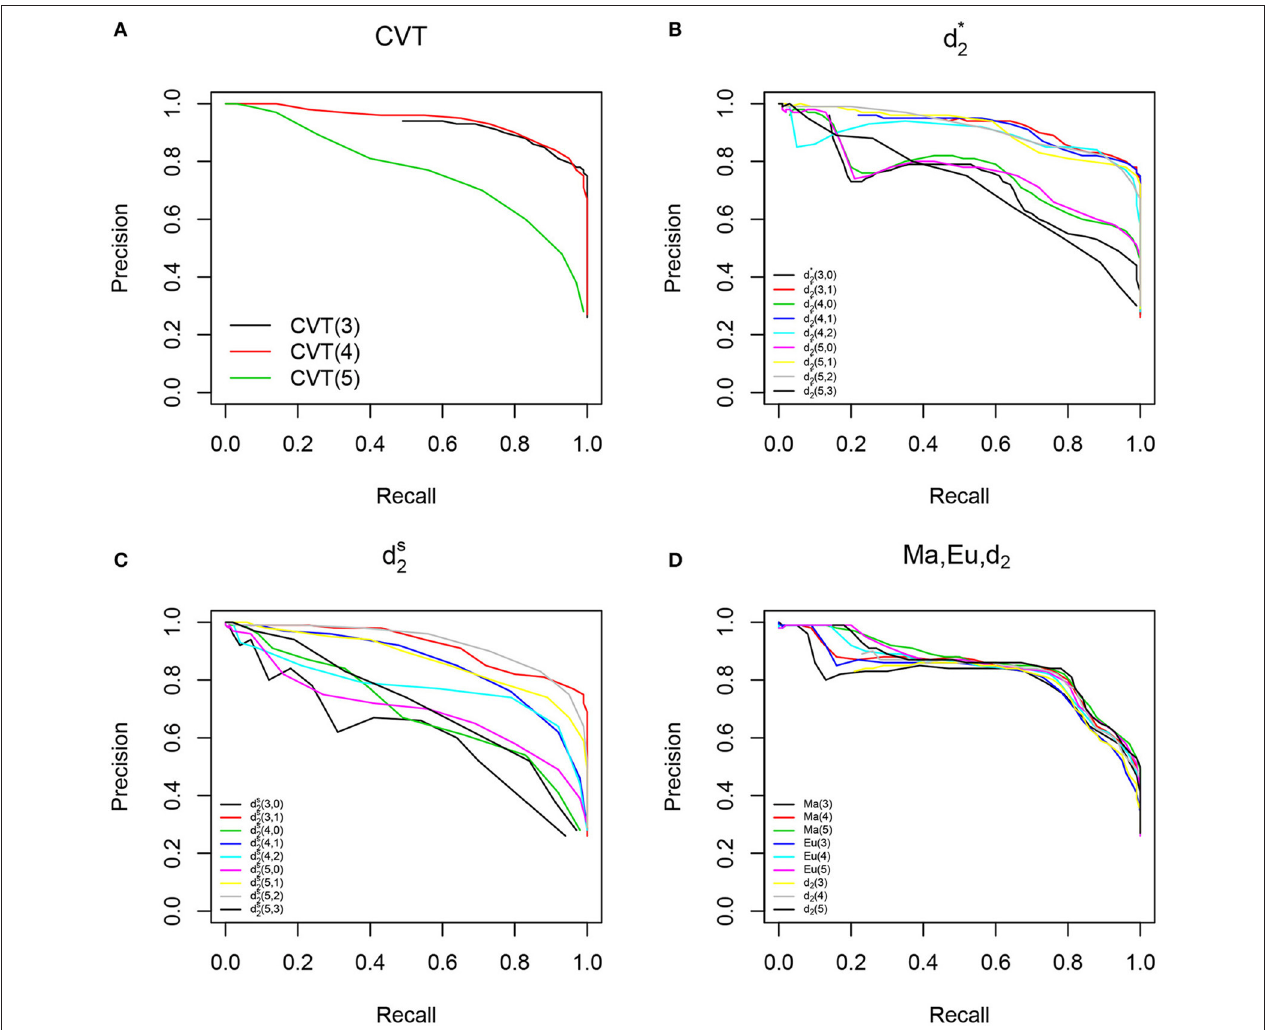
FIGURE 1 | Precision-Recall Curves (PRC) for all the methods. (A) Shows PRC for CVTree with different word lengths. (B) Shows PRC for all the d ∗ 2 methods. (C) Shows PRC for all d s 2 methods. (D) Shows PRC for Manhattan, Euclidean and d 2